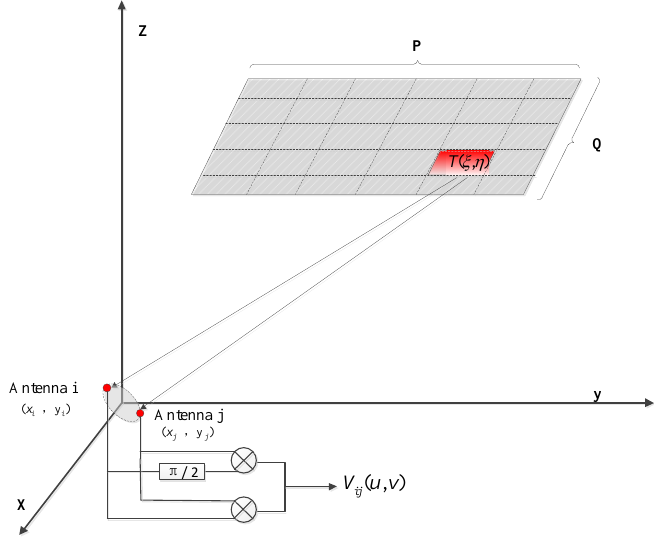
Figure 3. The schematic diagram of binary interferometer measurement.